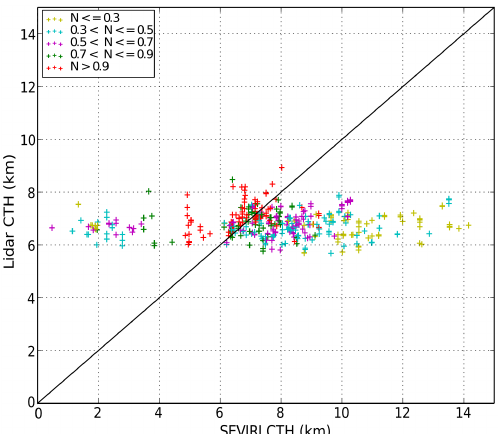
Figure 7. Scatterplot of CTH between SEVIRI and the aircraft datasets for all flights and all retrieval schemes. The altitude range of SEVIRI CTHs is much greater than the range of aircraft